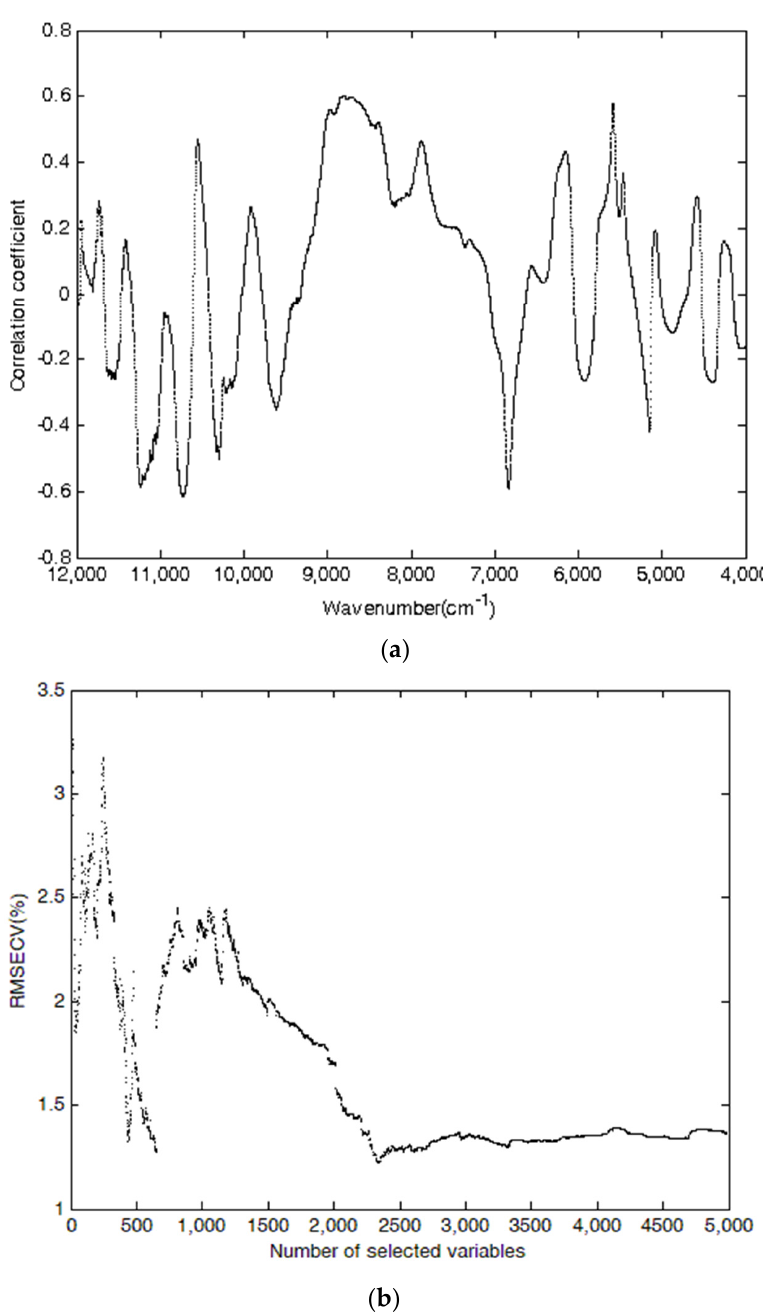
Figure 4. Plots of characteristic variable selection based on CC for cellulose in Sargassum horneri. Plots ( a ) and ( b ) show the correlation coefficient and RMSECV value, respectively.